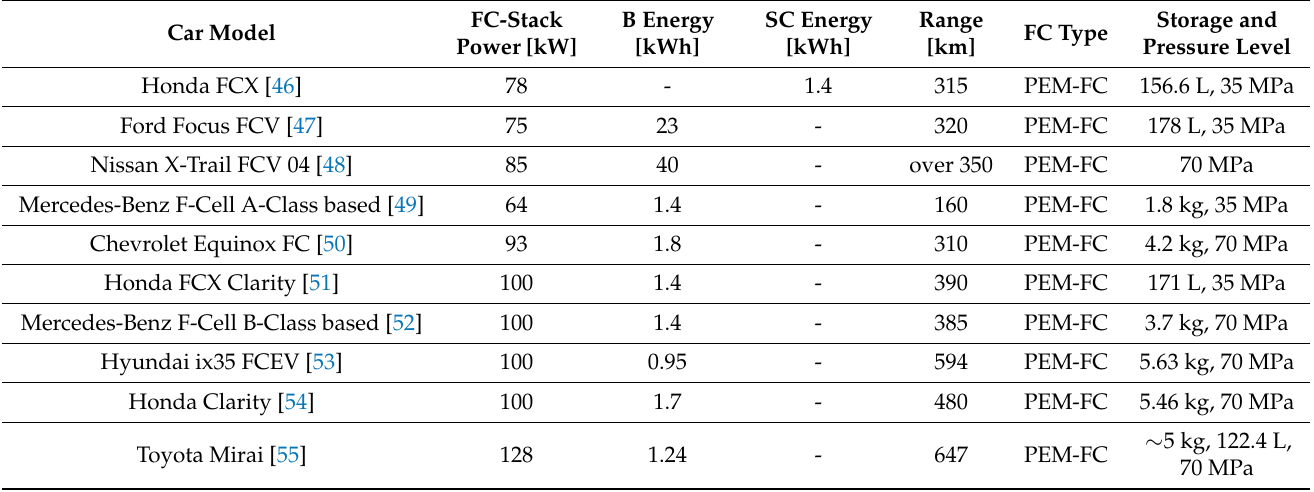
Table 4. List of fuel cell Cars and SUVs in production and out-of-production models with their